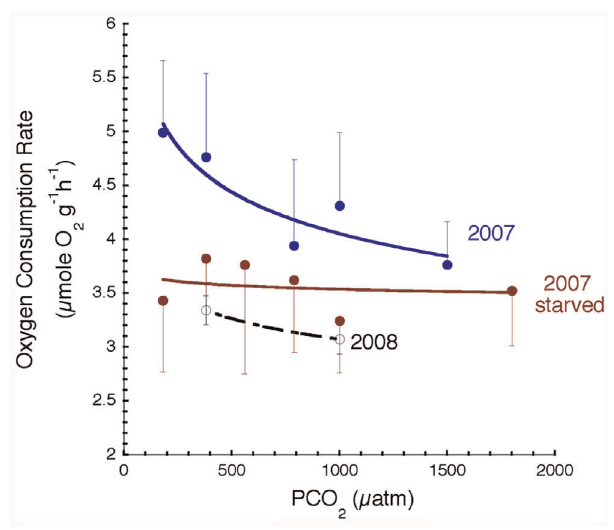
Figure 2. Oxygen consumption rates (MO 2 , m moles O 2 g 2 1 h 2 1 ) of the pteropod, Limacinahelicinaformaantarctica normalized to a common body mass (5 mg). At low PCO 2 , MO 2 of fed specimens (blue, fed = held less than 2 days prior to acclimation and measurement) are significantly higher than those held in captivity for 4–6 days prior to incubation and measurement (starved, red) in 2007. However, MO 2 in fed specimens declines strongly with increasing PCO 2 and MO 2 is similar between fed and starved specimens at high PCO 2 ( . 1500 m atm). Fed animals from 2008 (open circles, black) have similar rates to specimens starved in 2007 regardless of PCO 2 . Data are means and error bars are standard deviations.